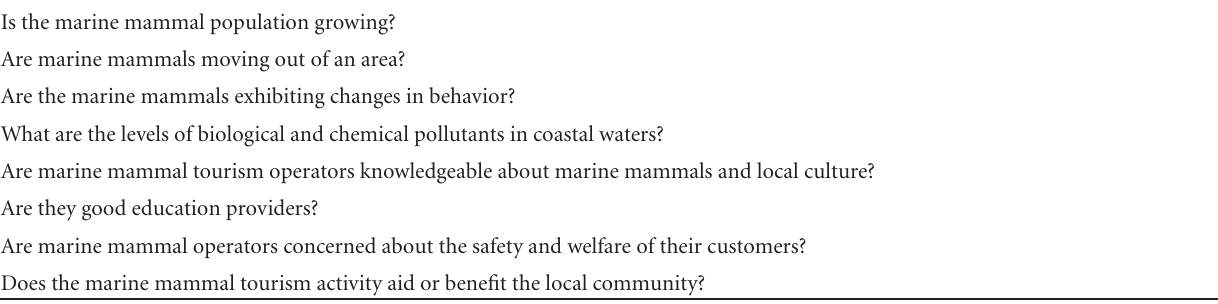
Table 2: A checklist of questions to ascertain whether whale watching is sustainable in a region (after [74]). Is the marine mammal population growing? Are marine mammals moving out of an area? Are the marine mammals exhibiting changes in behavior? What are the levels of biological and chemical pollutants in coastal waters? Are marine mammal tourism operators knowledgeable about marine mammals and local culture? Are they good education providers? Are marine mammal operators concerned about the safety and welfare of their customers? Does the marine mammal tourism activity aid or benefit the local